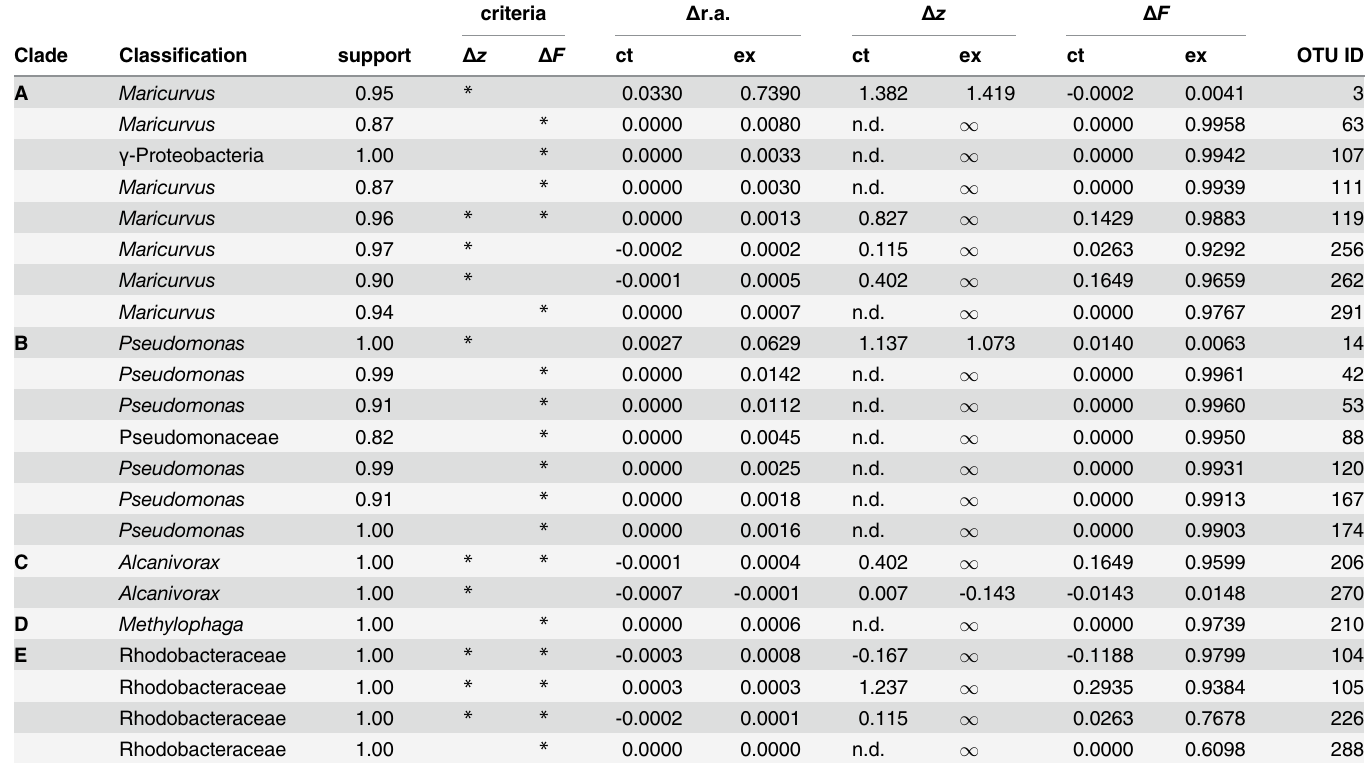
Table 1. OTUs with dynamic behavior in response to amendment with